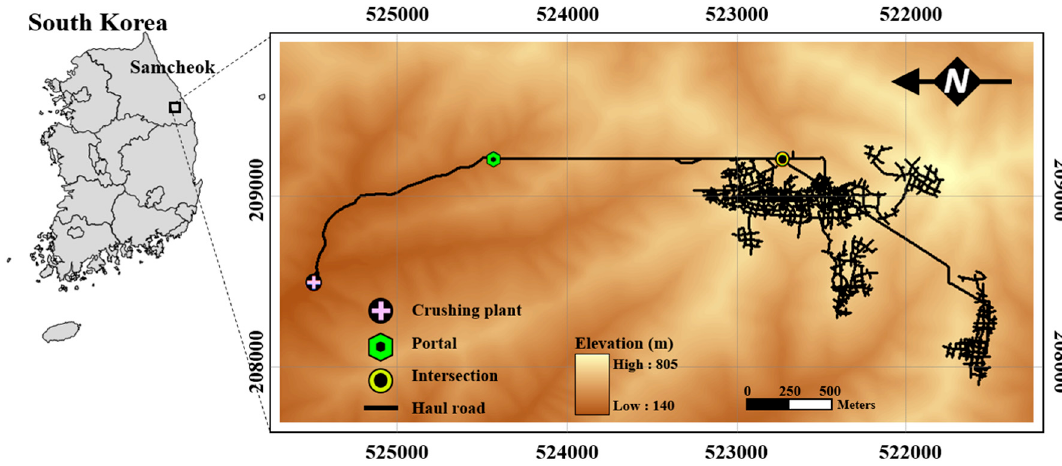
Figure 1. Illustrations of the study area. The reference grid is in m. The origin of the local Transverse Mercator coordinate system is 38 ◦ 00 (cid:48) 00 (cid:48)(cid:48) N, 127 ◦ 00 (cid:48) 00 (cid:48)(cid:48) E (map datum: